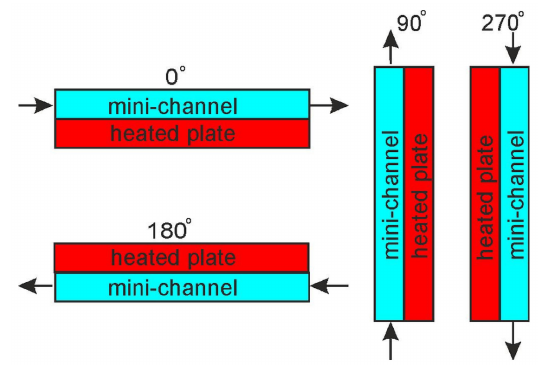
Figure 4. Spatial orientations of the test